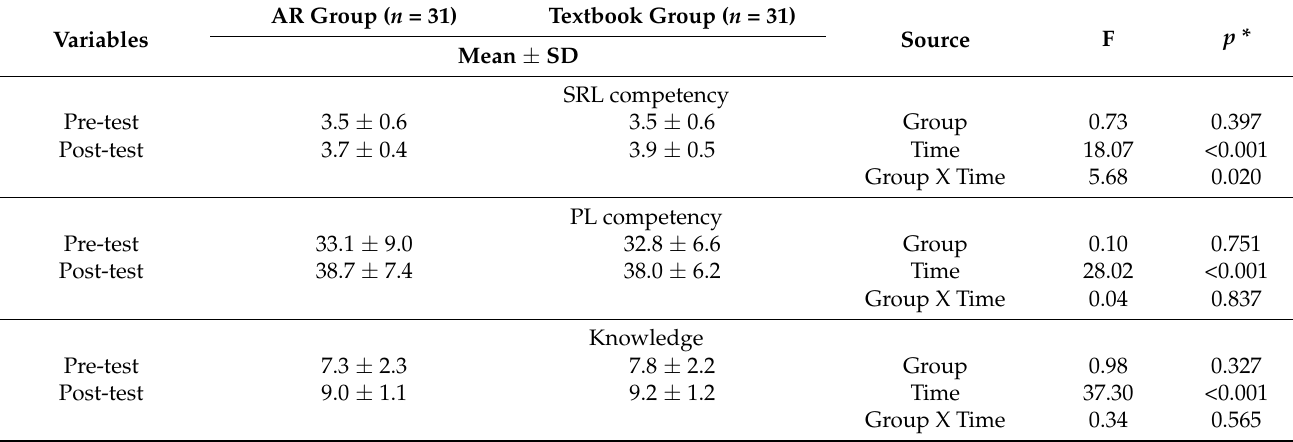
Table 2. Comparison of intervention effect between Groups ( n =